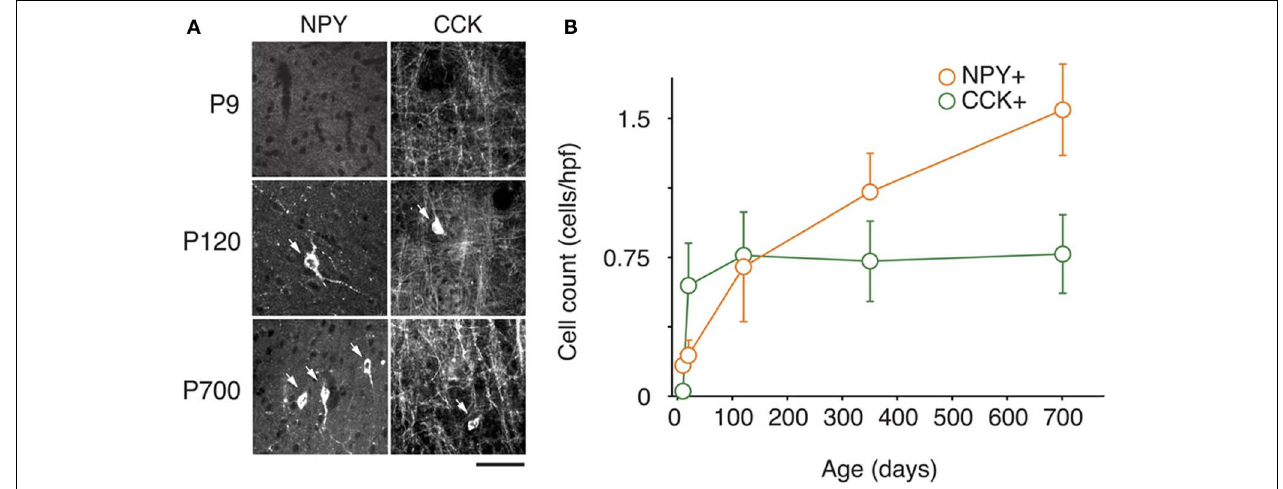
FIGURE 3 | Changes in NPY and CCK expression in A1 during life. (A) Representative high power micrographs of NPY + (left) and CCK + immunolabeled cells (right) at three age intervals. The arrows mark the